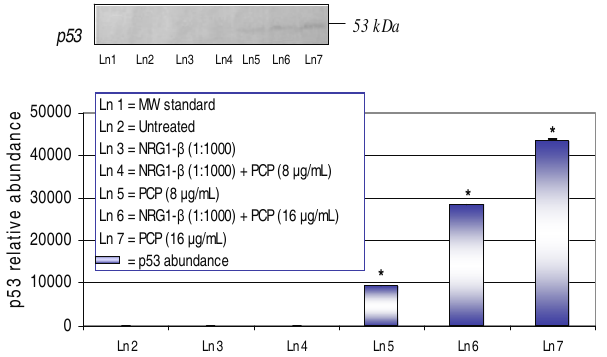
Figure 6: Expression and relative abundance of p53 in AML 12 mouse hepatocytes exposed to PCP and NRG1- β + PCP for 48 h . assessed following exposure incubation period of 48 h. Inset shows representative Western blot analysis. Each point represents a mean value and standard deviation of three independent experiments. *Significantly different ( p < 0.05 ) from untreated (0 µg/mL) and NRG1- β (1:1000) treated